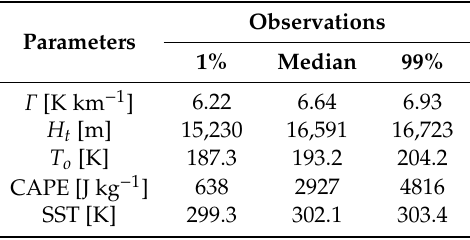
Table 1. The values of the environmental parameters obtained from the JRA-55 analysis. The 1st percentile, median, and 99th percentile values are